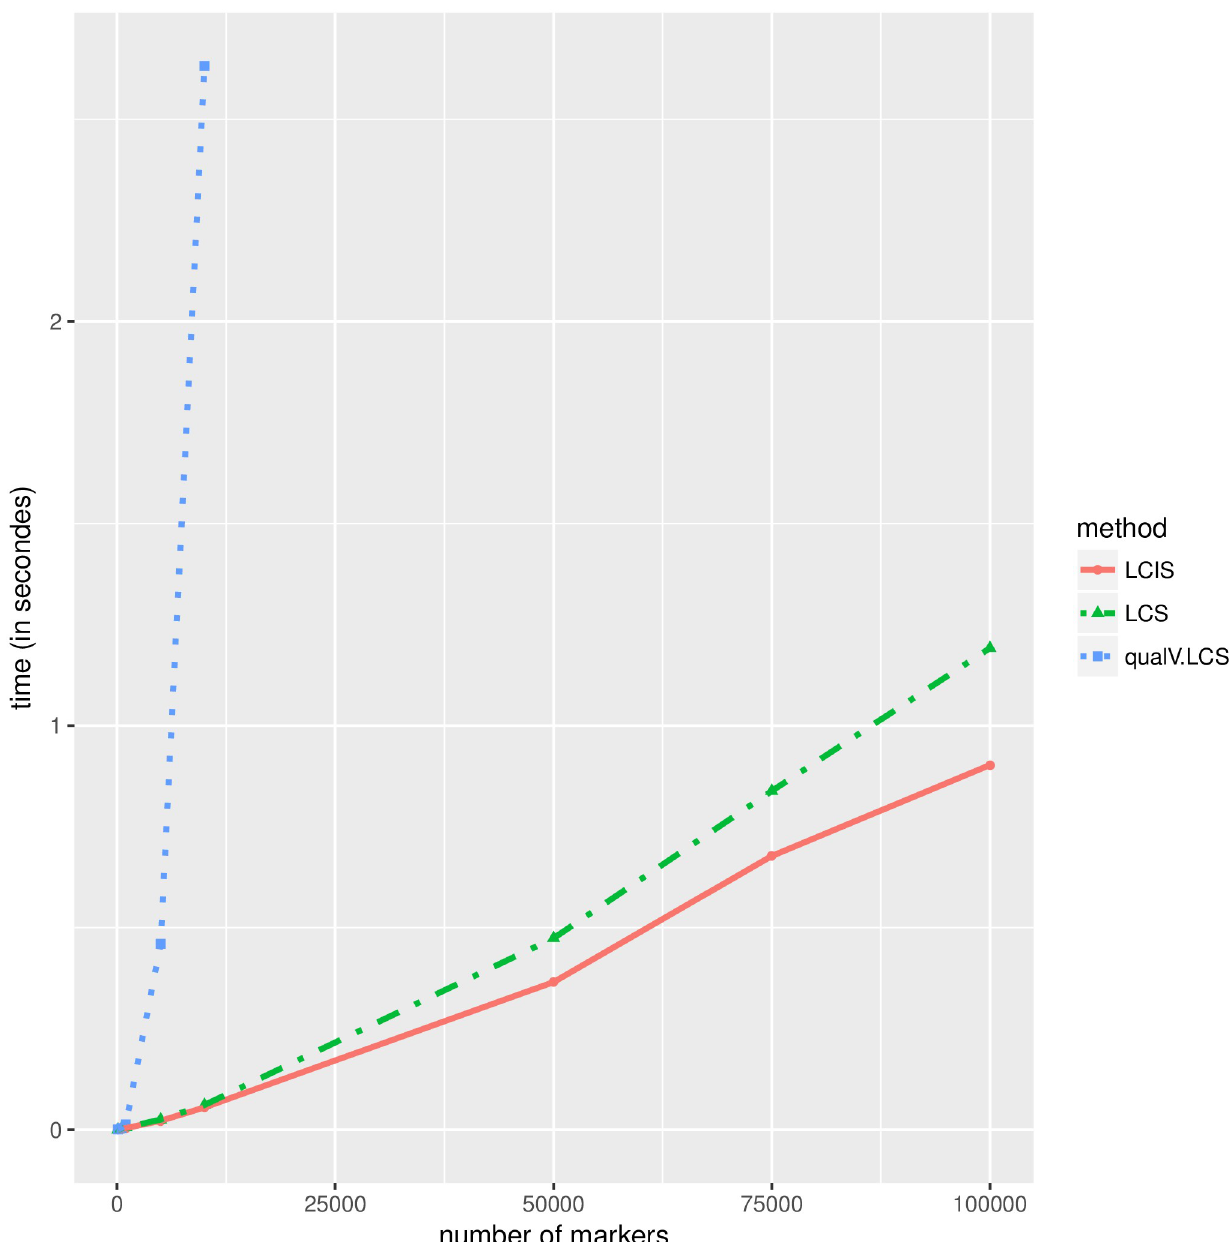
Fig 6. Comparison of computation times in seconds (Y axis) needed to compute LC(I)S for an increasing number of markers (X axis). Three methods are compared: our bucket dedicated methods to compute 1/ LCS (dashed green line) or 2/ LCIS (plain red line) and 3/ a brute force solution ignoring bucket order specificities and relying on the LCS function of the qualV package (blue dotted line). This latter solution is unable to handle large dataset, and crashes the Rstudio environment when called with the 50000 marker dataset whereas our solutions easily handle much larger datasets in